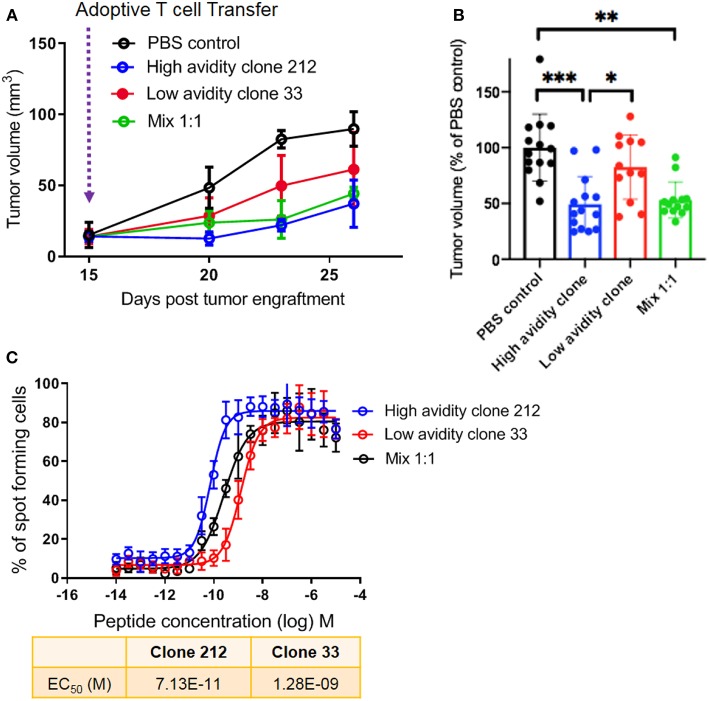
In vivo protective capacity of T cell clones in humanized mice. (A) 6 to 8 weeks old NSG-A2 mice (groups of 5 mice) were injected subcutaneously on the right flank with 2 × 106 human Me275 melanoma cells. Once the Me275 tumors became palpable at around D23 post tumor engraftment, 1 × 106 of a high avidity T cell clone (blue), a low avidity T cell clone (red) or a 1:1 mixture of the two clones (green) were injected intravenously in the tail vein. The results are from one of three representative experiments. (B) Average ± standard deviation, and statistical comparisons (One-way Anova) of tumor volumes at the end of three repeat experiments, substantiating the results in (A). P-values ***<0.001; **<0.01; *<0.05. (C) IFN-γ Elispot data from the clones used in vivo, showing the two distinct functional avidities.